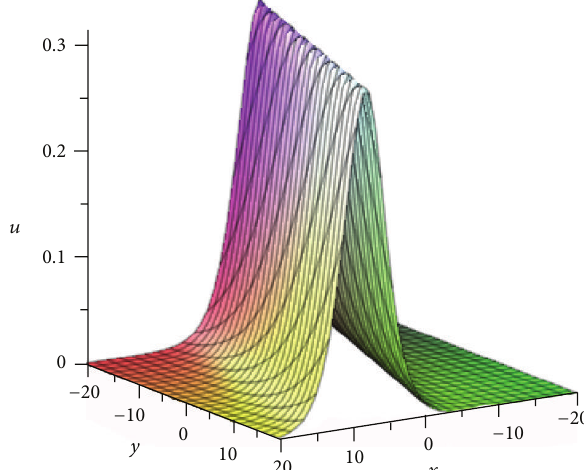
= 1 , 𝑐 = 2 , 𝜉 0 = 1 , 𝜉 0 = 1 , 𝑡 = 2 . 1 2 1 2